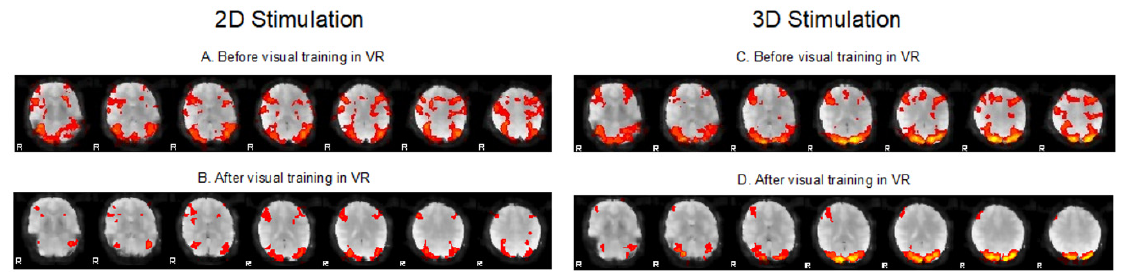
Figure 3. fMRI activation voxels showing activity in specific parts of the brain. ( A , B ) Comparison of fMRI before and after virtual reality-based training using a 2D stimulus (brain axial section set). The paradigm involved changing the Titmus 2D test and fixation image. See decreased activity in the frontal, parietal, and occipital lobes after treatment. ( C , D ) Comparison of fMRI before and after virtual reality-based training using a 3D stimulus (brain axial section set). The paradigm involved changing the Titmus 3D test and the fixation image. See decreased activity in frontal, parietal, and occipital lobes after treatment.